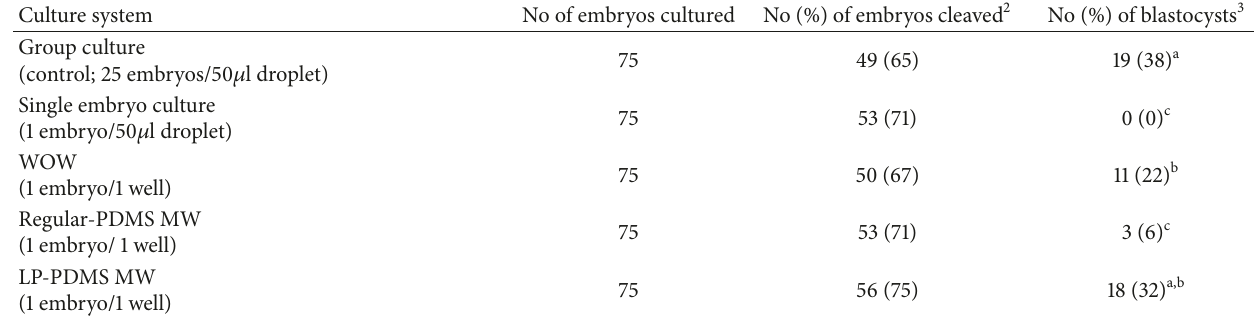
Table 1: In vitro development of bovine IVF embryos cultured with PDMS MWs 1